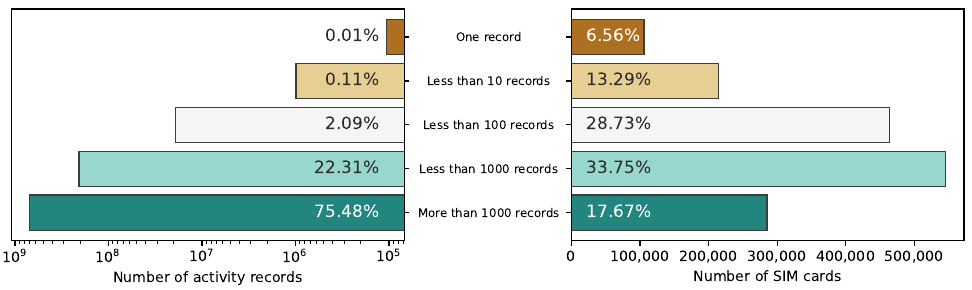
Figure 3. The SIM cards in the “April 2017” data set categorized by the number of activity records. The SIM cards over a thousand records (17.7%) provide the majority (75.48%) of the activity.